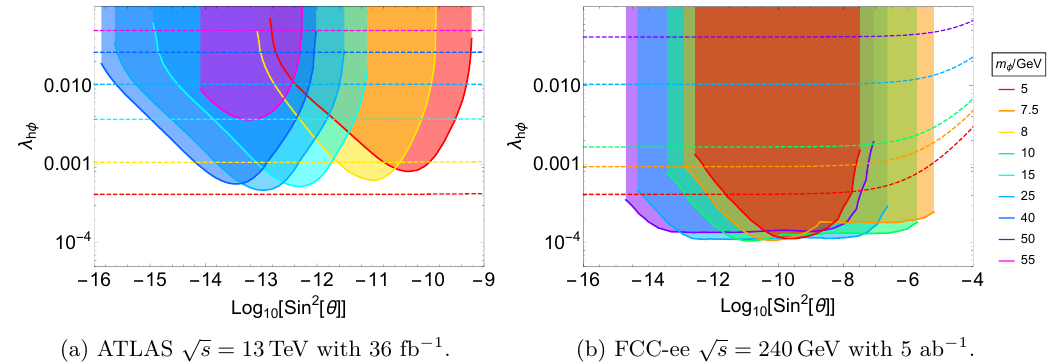
Figure 4 . Bounds on λ hφ and sin 2 θ for various singlet masses arising from searches for displaced jets in Higgs decays. The dashed lines show the upper naturalness limit λ max